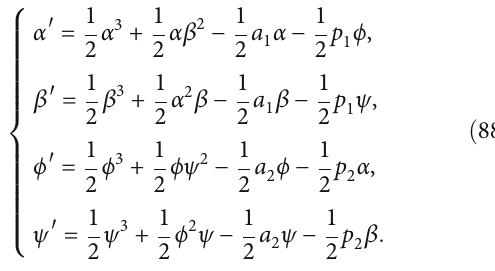
ffiffiffiffiffiffiffiffiffiffiffiffiffiffiffiffiffi 2 s